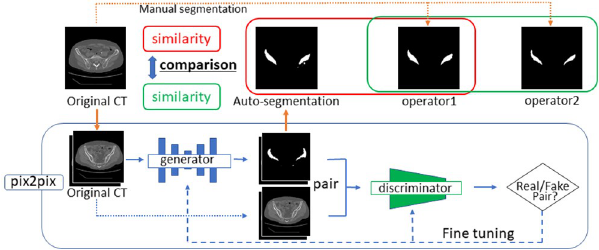
Fig 1. Overview of proposed automatic segmentation